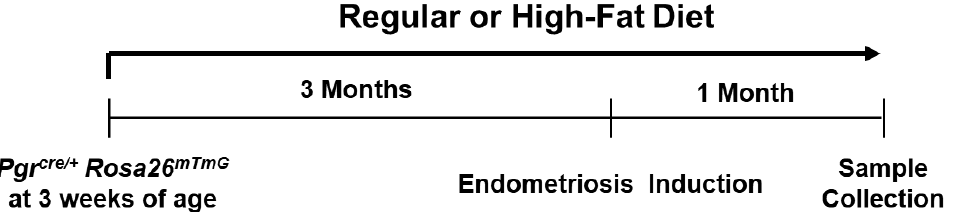
Figure 1. Experimental design to evaluate the effects of diet-induced obesity on endometriosis. Female Pgr cre/+ Rosa26 mTmG mice were feed a high-fat or regular diet to induce obesity at 21 days of age. Three months after obesity induction, endometriosis was surgically induced. The effect of diet-induced obesity on endometriosis was evaluated by examining number and weigh of ectopic lesions.